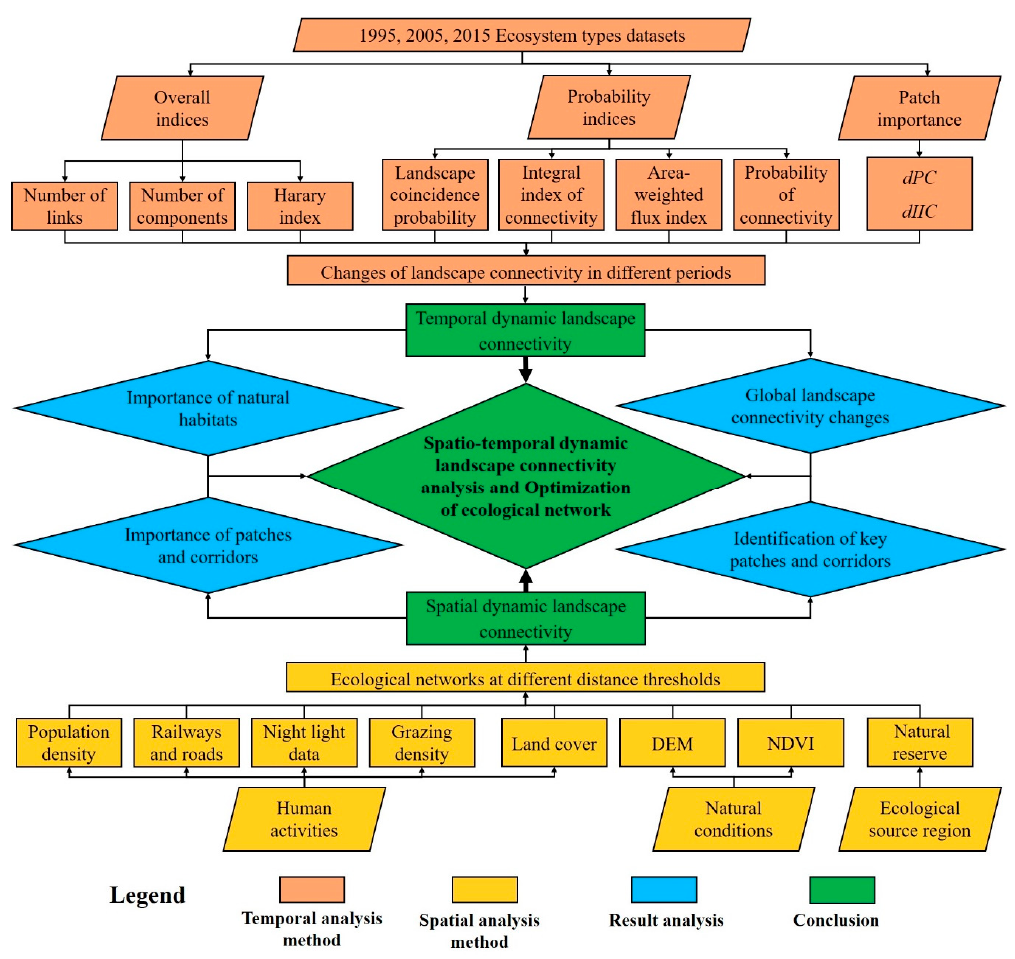
Figure 2. Schematic diagram of the study framework.